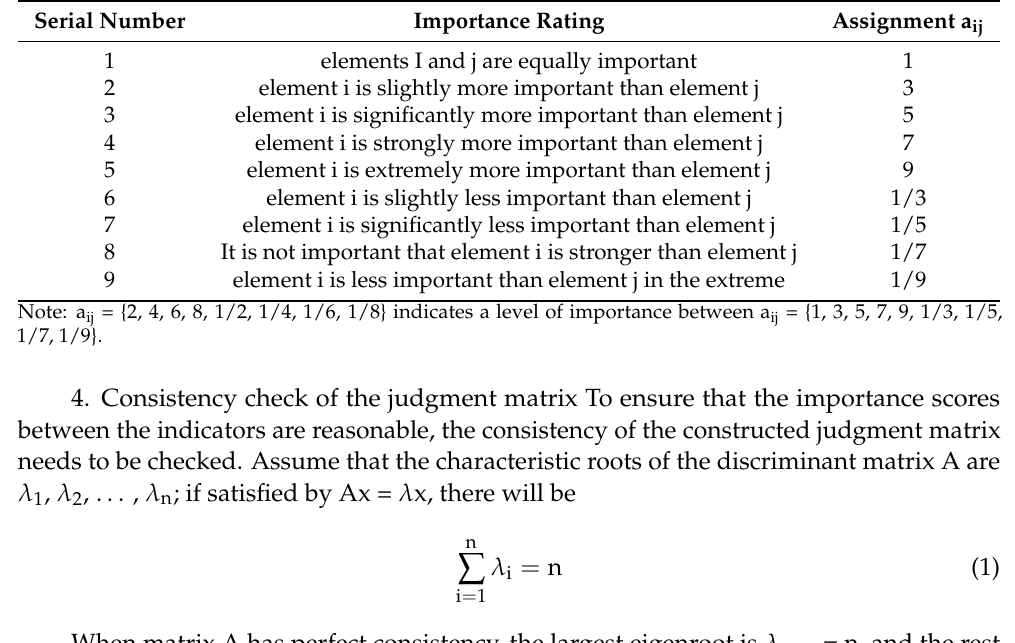
Table 2. 1–9 scale